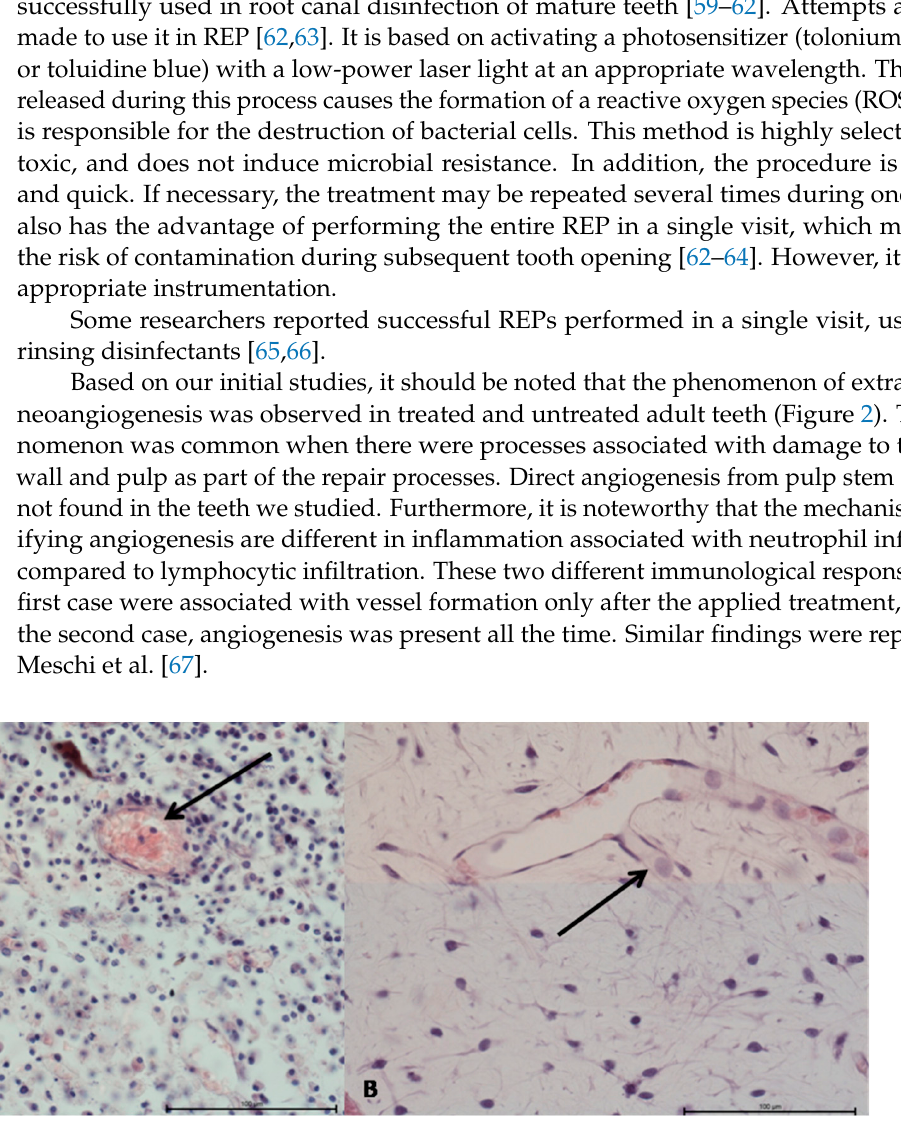
Figure 2. Human molar tooth. ( A ) Inflammation of the tooth pulp. Blood-filled blood vessels are visible (arrow), surrounded by a moderate macrophage–lymphocytic infiltrate. ( B ) Angiogenesis (arrow) in human dental pulp (H&E stain enl. 400×).